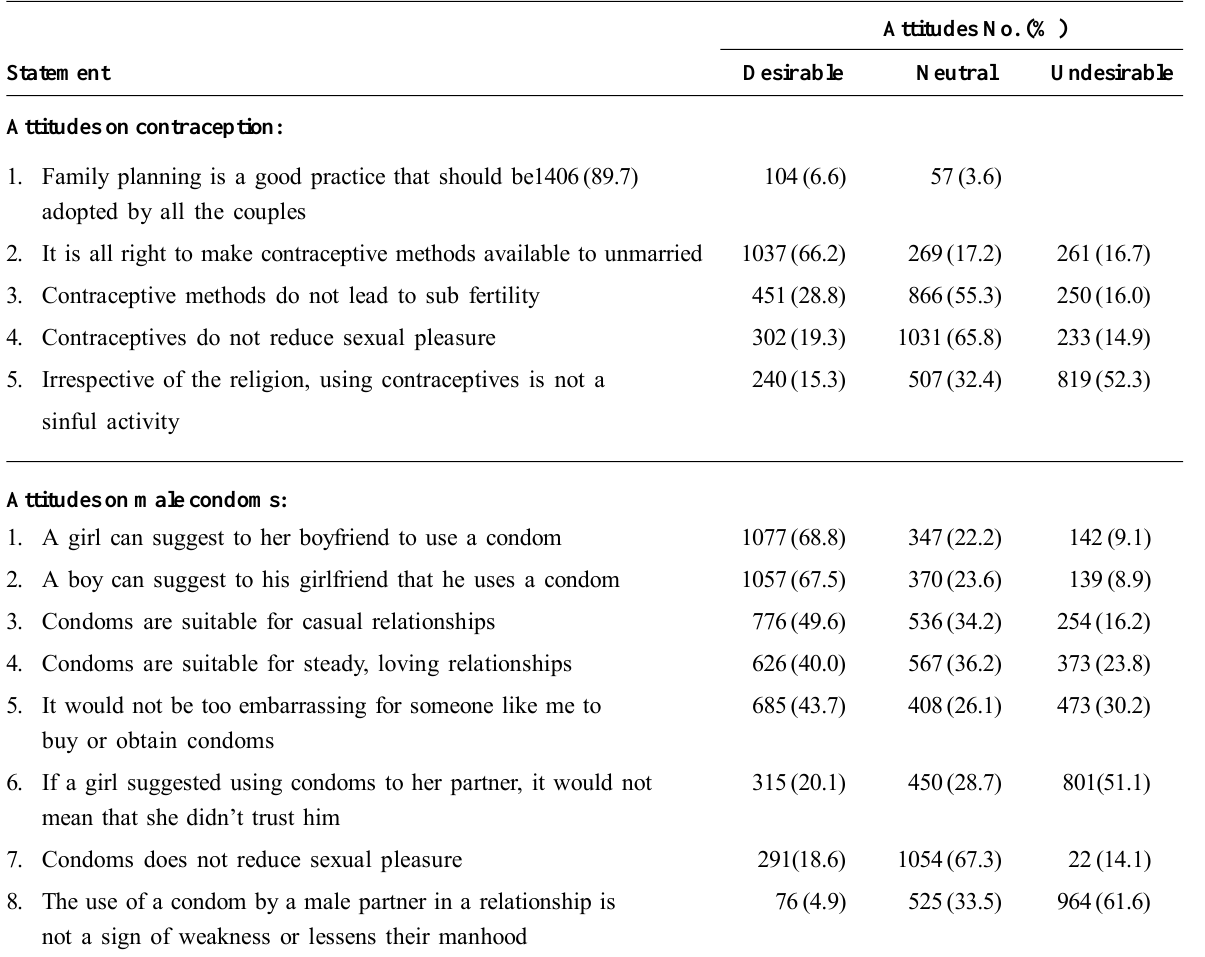
Table 3. Frequency distribution of the attitudes on contraception and condom use (N = 1575)